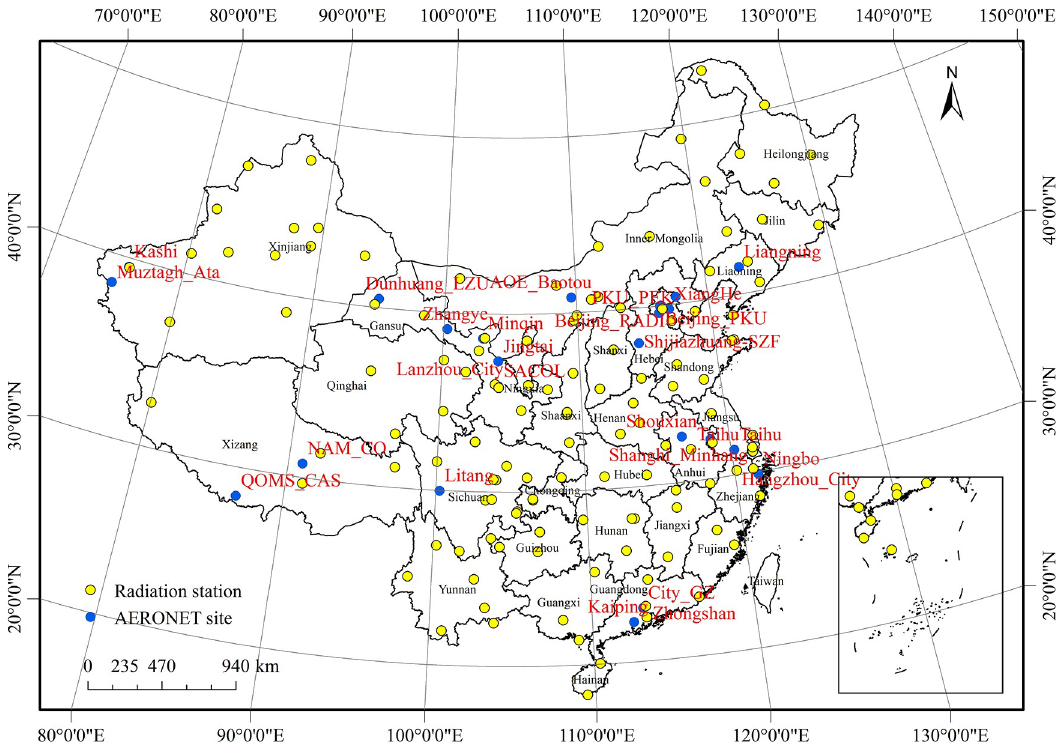
Fig 1. Distribution of the AERONET site and radiation station in China selected in this